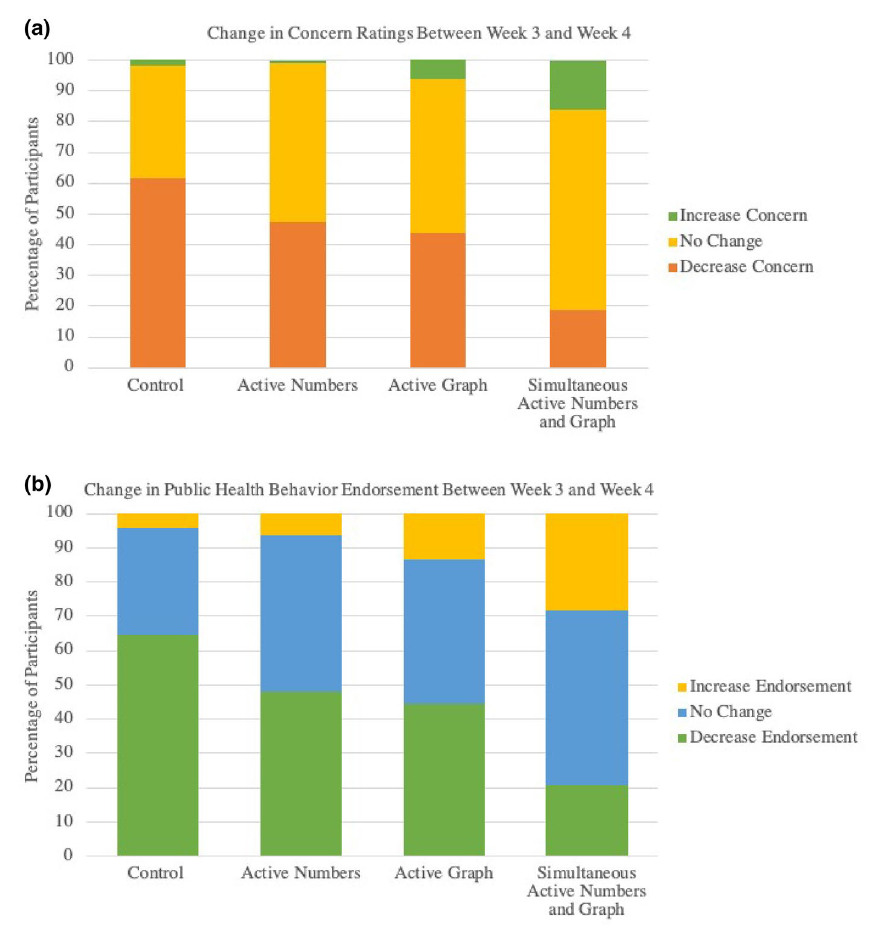
Figure 4. ( a ) Perecent of participants who changed concern ratings between week 3 and week 4. ( b ) Perecent of participants who changed endorsement for public health behaviors between week 3 and week 4.